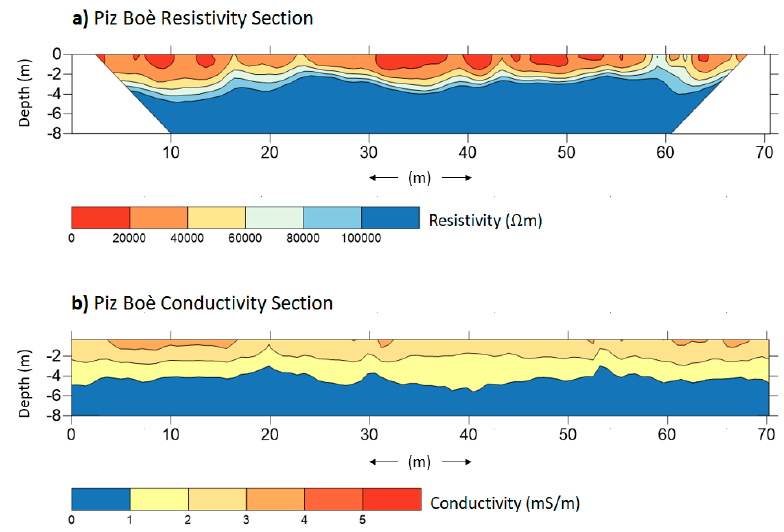
Figure 6. Inverted ( a ) resistivity and ( b ) conductivity sections obtained with ERT and FDEM surveys performed with an investigation line orthogonal to the development of the Piz Boè rock glac- ier.